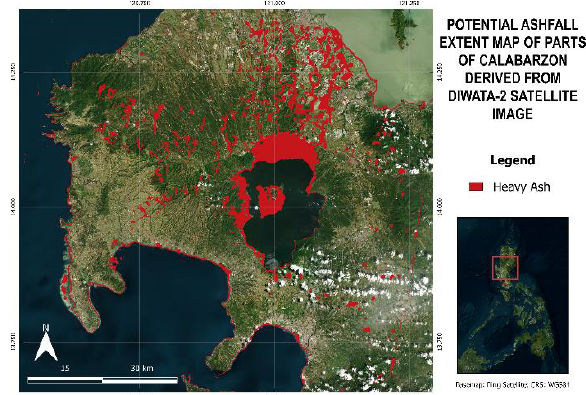
Figure 6. Potential ashfall extent map over parts of CALABARZON based on DIWATA-2 satellite imagery Figure 4. Hotspot map of ashfall-affected locations obtained by KDE